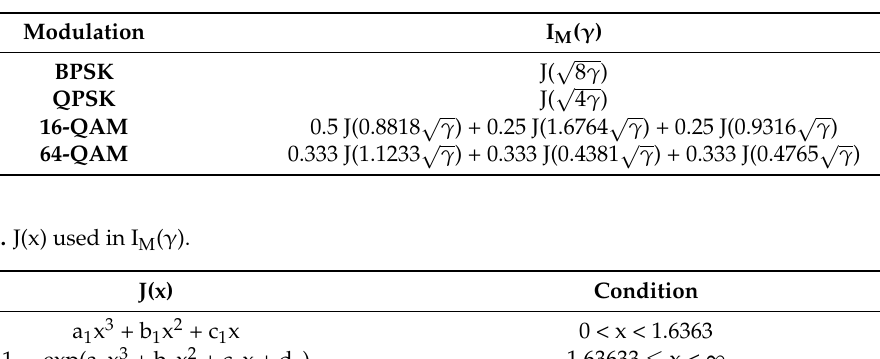
Table A1. SNR-to-MI equations in terms of J(x).